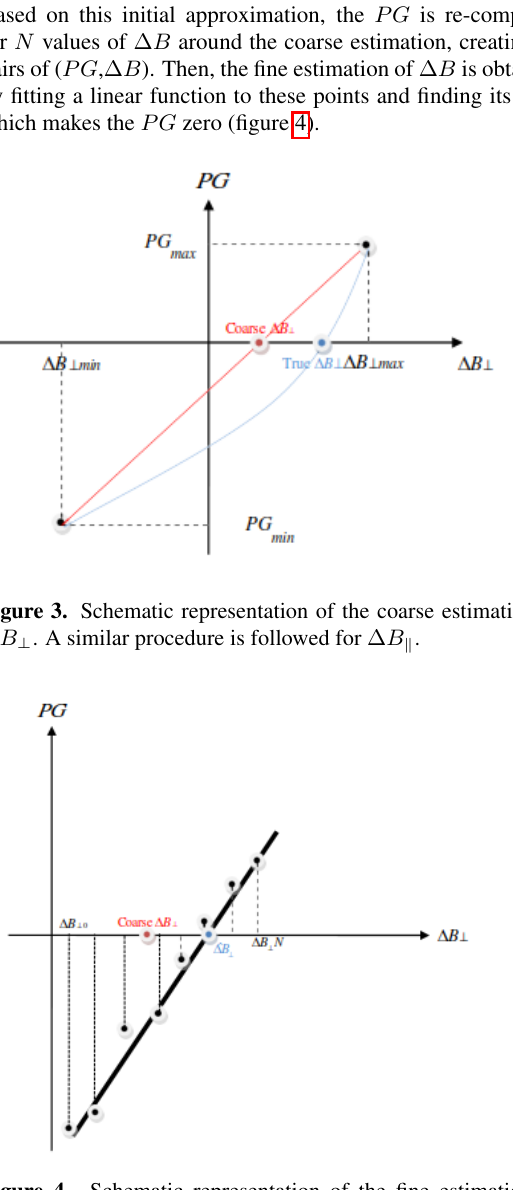
Figure 4. Schematic representation of the fine estimation of ∆ B ⊥ , based on the initial coarse estimation. A similar procedure is followed for ∆ B (cid:107)